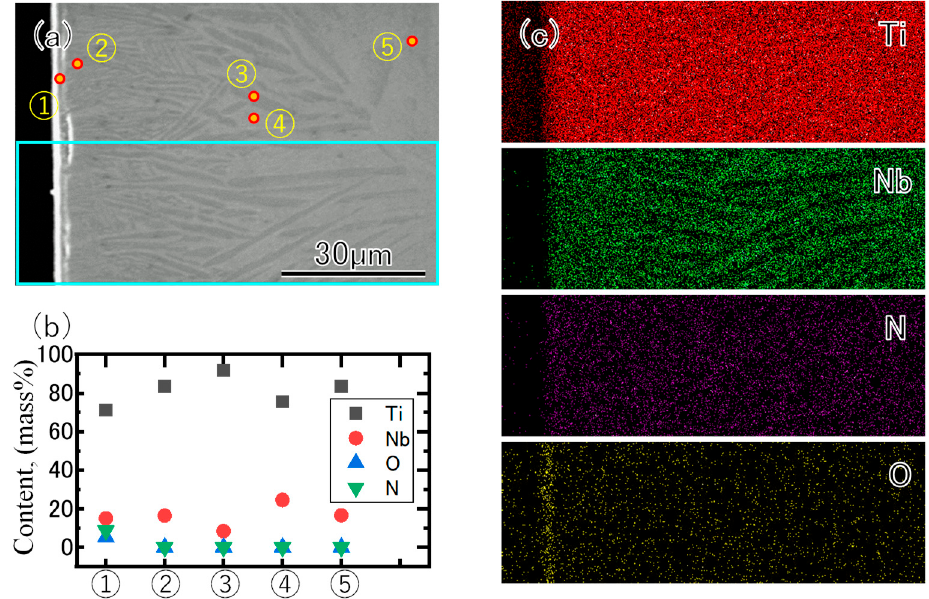
Figure 4. Cross-sectional SEM-EDX analysis results after GNQP at 1023 K. ( a )SEM microstructure. ( b ) The result of point analysis at the position indicated by the number of ( a ). ( c ) The element mapping results of Ti, Nb, N and O.